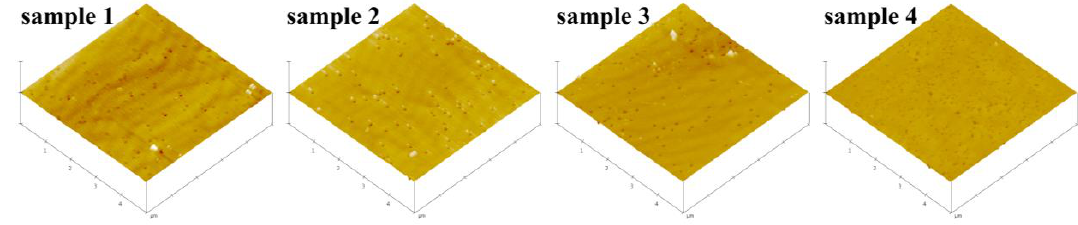
Figure 2. Atomic force microscopy (AFM) images of AlInGaN epilayers with different TMA flow rate; the scan area is 5 × 5 μm 2 .